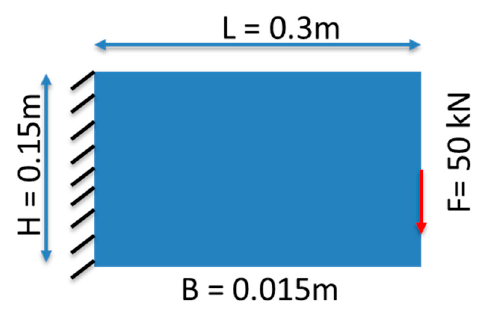
Figure 2. Selected domain for the design approach in this investigation.